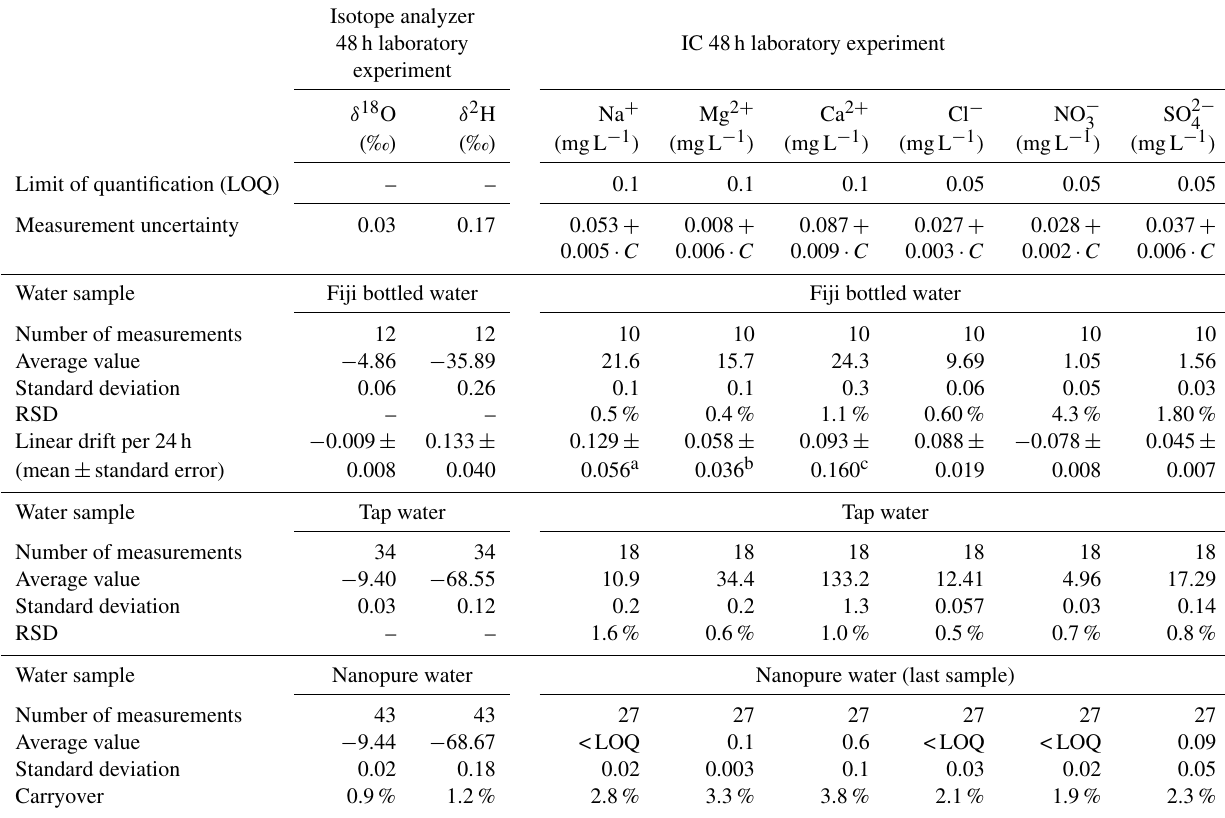
Table 1. Average isotope values and solute concentrations as well as standard deviations (and relative standard deviations; RSDs) of three water samples analyzed during two different 48h laboratory experiments with the isotope analyzer and the IC, respectively. In Fiji bottled water, tap water, and nanopure water, concentrations of F − , Li + , K + , NH + and thus were not included in the table. The calculation of the average memory coefficient is described in the text (Eq. 1). The uncertainties in the IC measurements were obtained by simple linear regression analysis of the average value and the standard deviation of the respective